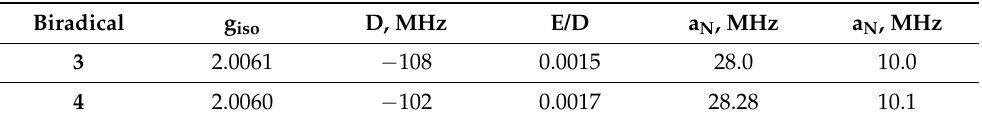
Table 3. Spin Hamiltonian parameters for triplet biradicals 3 and 4 , as calculated at the DFT level (see details in Section 3.3).